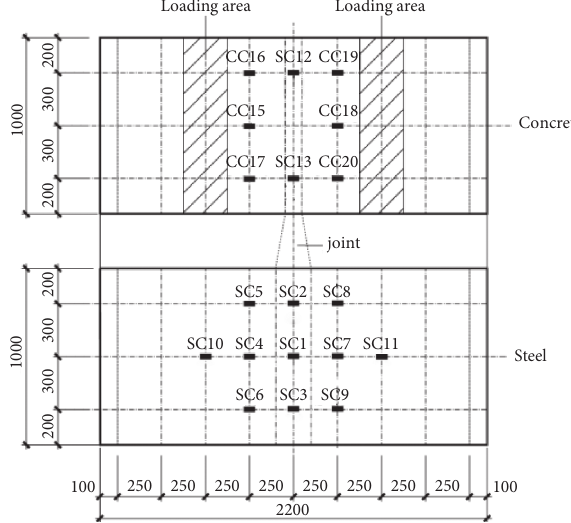
Figure 12: Arrangement of strain measuring points for jointed specimens in flexural experiment.